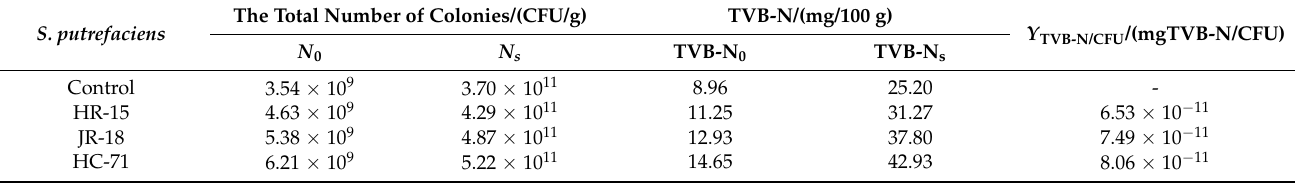
Table 4. The yield factors of the TVB-N of the tilapia flesh inoculated with different S . putrefaciens strains (HR-15, JR-18, and HC-71) during refrigerated storage at 4 ◦